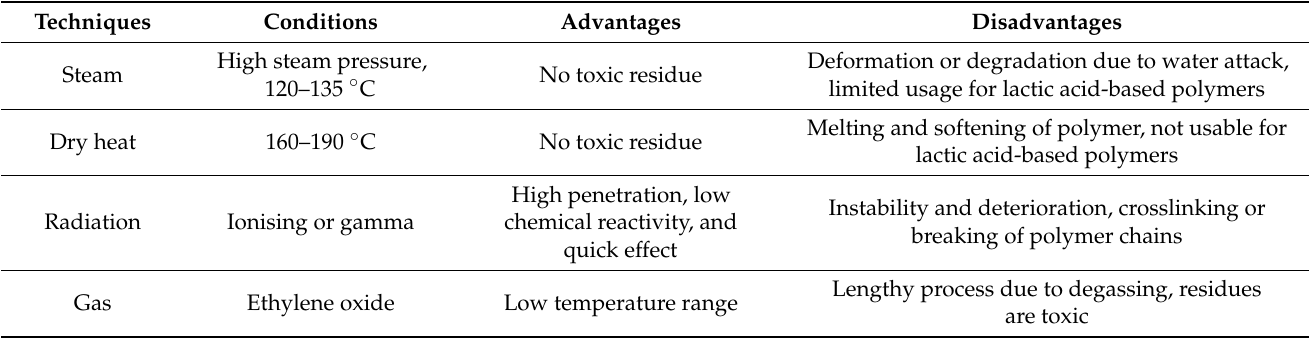
Table 10. Sterilisation techniques and their advantages and disadvantages for use with PLA.